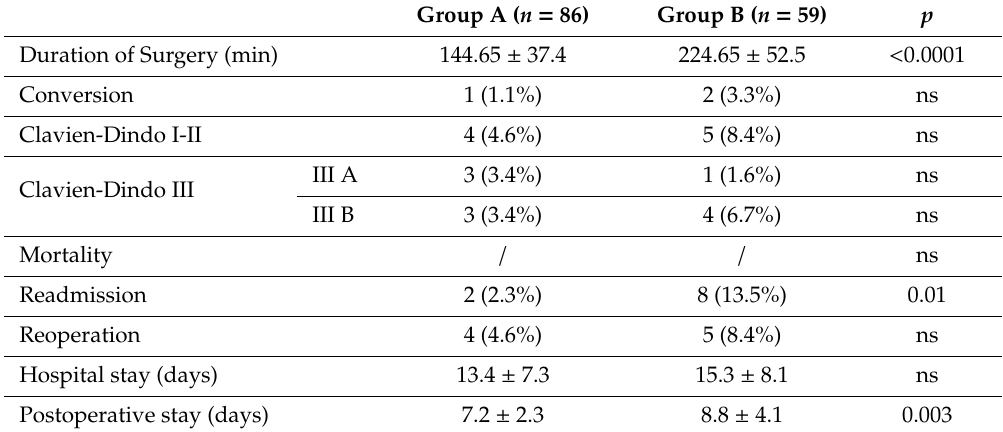
Table 2. Comparisons of surgical